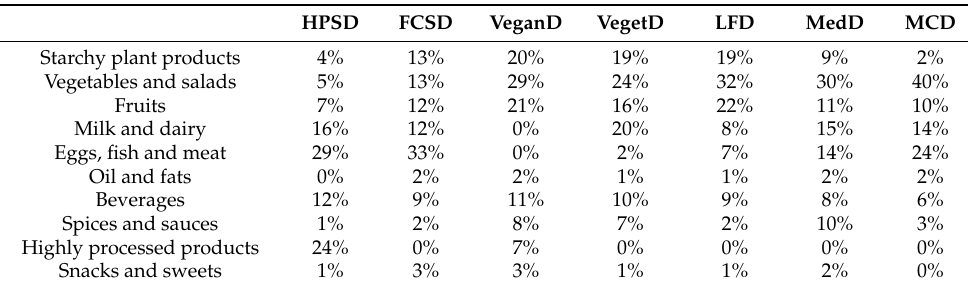
Table 6. Price proportions according to food